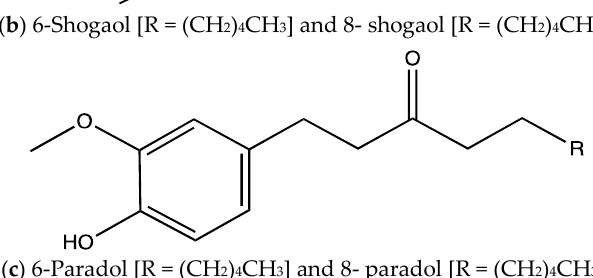
Figure 15. Chemical structures of different gingerols ( a ), shogaols ( b ) and paradols ( c ). To evaluate the antiplatelet effects of Z. officinale powder, a placebo-controlled study examined the effect of a daily dose of 4 g of Z. officinale extract capsules on patients ( n = 30) with acute myocardial infarction (more than 6 months). Patients were asked to stop their daily dose of aspirin for 2 weeks before the beginning of the study. Blood samples were collected after 45 and 90 days of administration and PRP aggregation was performed using ADP and epinephrin as agonists. Although the effect of Z. officinale on platelet ag- gregation was insignificant, a single 10 g dose led to a reduction in PRP aggregation of nearly 25% against ADP and epinephrin-induced activation after 4 h from administration.